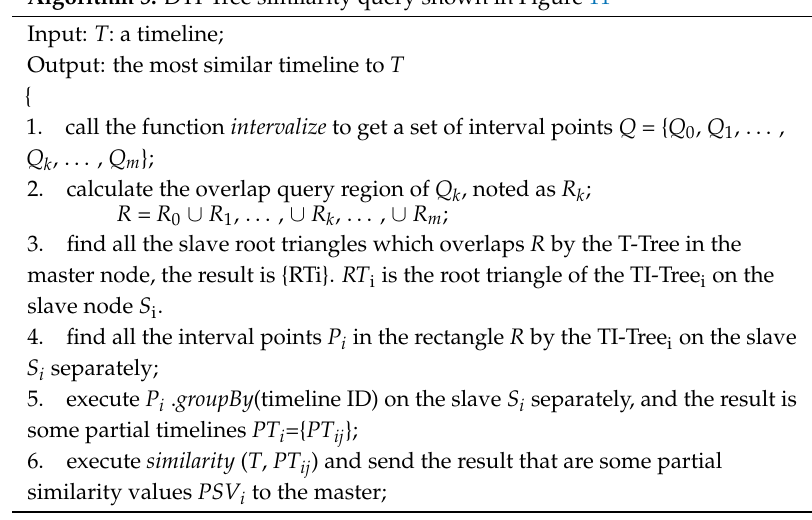
Figure 11. Main steps of similarity query. Algorithm 5: DTI-Tree similarity query shown in Figure